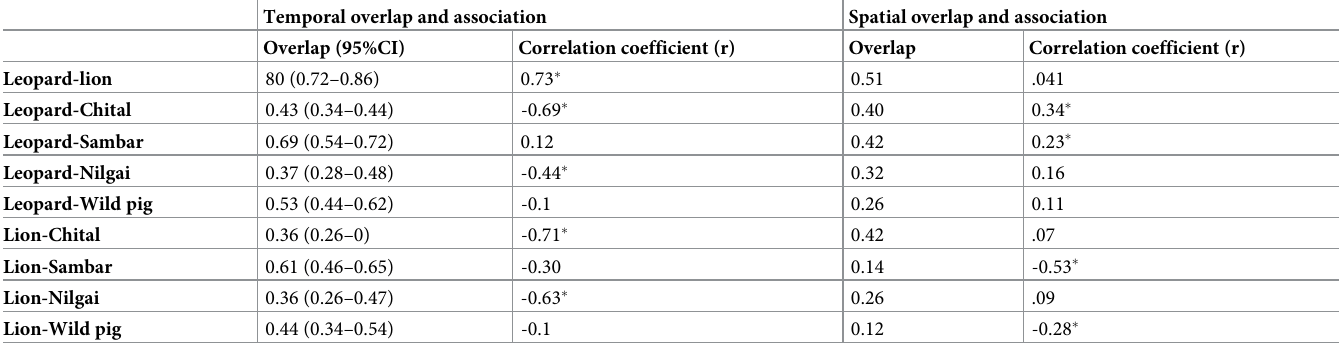
Table 2. Spatial and temporal overlap and association between leopard and lion and with their prey. Temporal overlap and